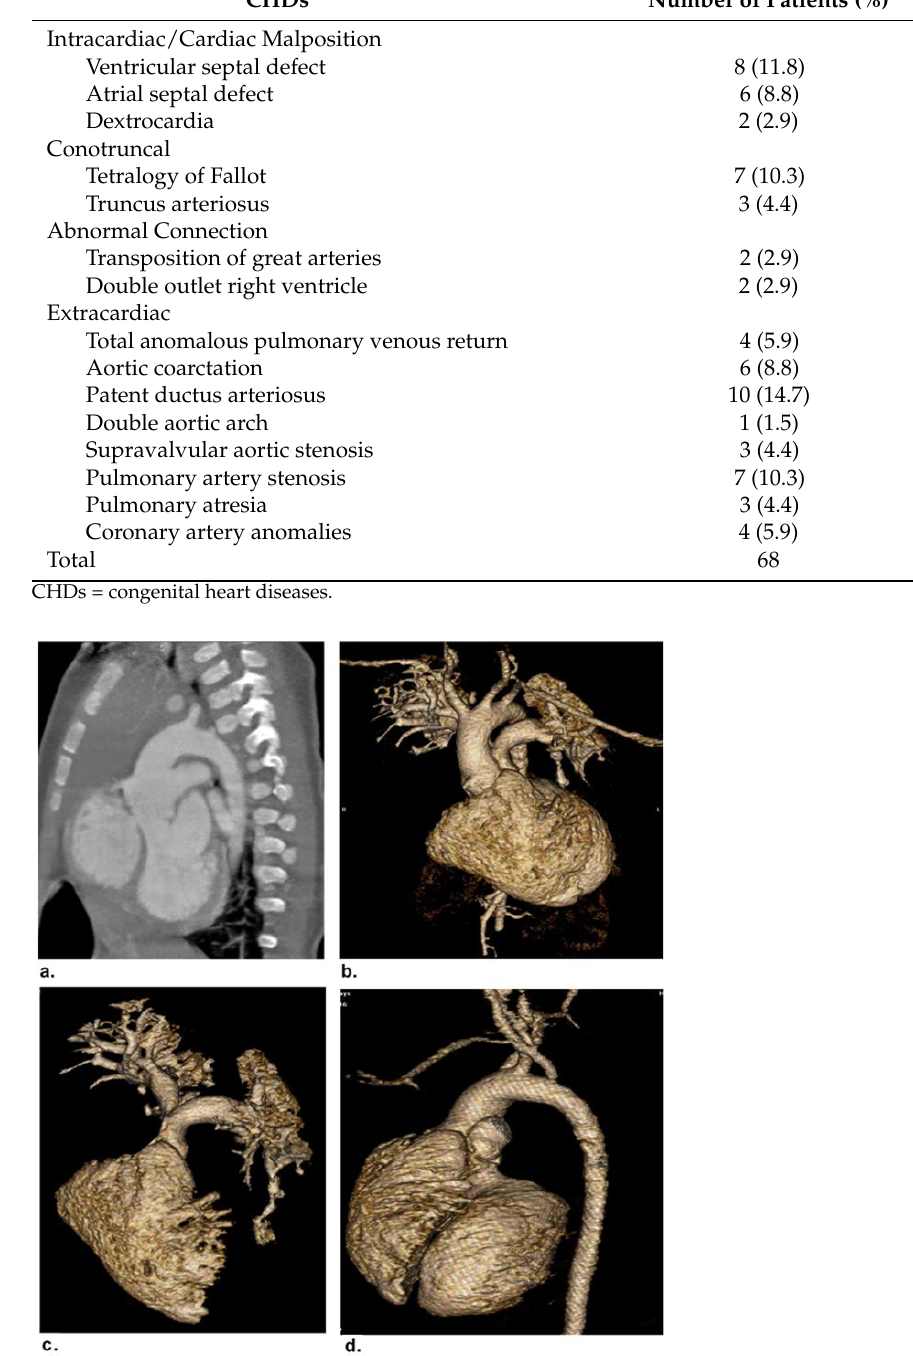
Figure 2. A 5-month-old male patient with truncus arteriosus Type I. ( a ) Curved MIP and ( b ) 3D-VR image showing a common arterial trunk arising with a single prominent truncal valve overriding both ventricles. The trunk measures 9 mm in length and 19 mm in diameter, along with cardiomegaly with dilatation of all chambers, predominantly right-sided, and VSD with overriding prominent truncal valve. ( c ) 3D-VR image showing a short MPA trunk arising from the left posterolateral aspect of the common trunk. This short MPA trunk measures 3.5 mm in length and 10 mm in diameter. The RPA shows a relatively tight segment (arrow) measuring approximately 2.5 mm in length and 4.5 mm in diameter at its origin. ( d ) 3D-VR image at the level of the MPA origin. The ascending aorta is seen arising from the right lateral aspect of this trunk.